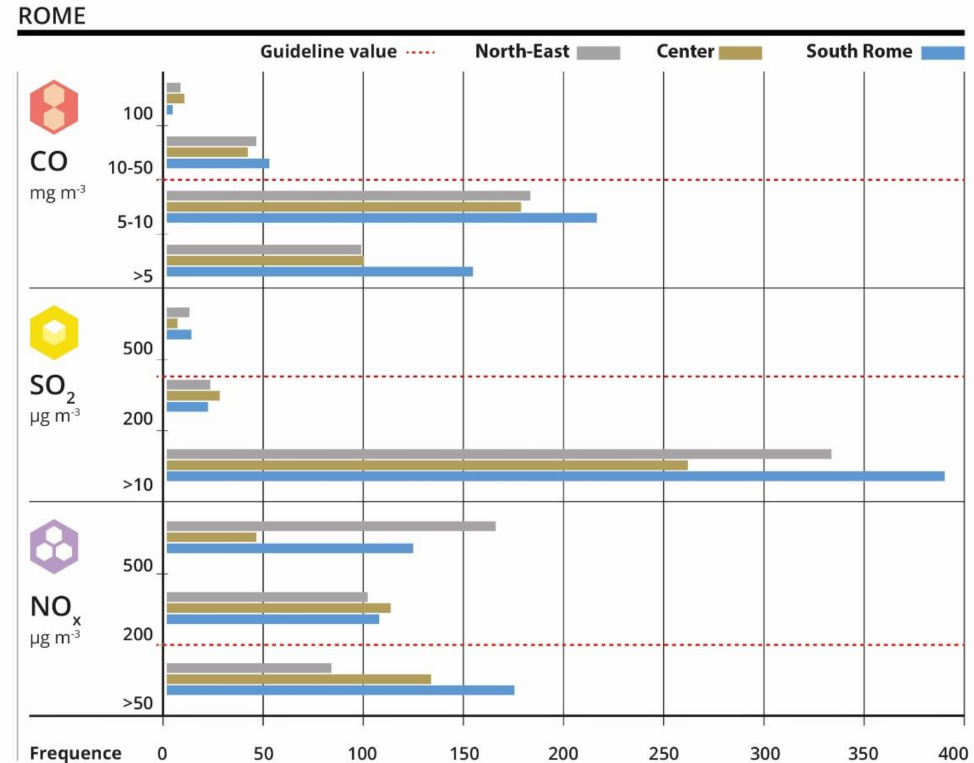
Figure 6. Frequency of the concentration classes of the three gases, CO, SO 2 and NO x , grouped by geographic areas. The histograms indicate the gas concentrations averaged with respect to the areas of the City of Rome, gray for the Northeast, bronze for the Center, and blue for the South. The symbolism of the gases is that adopted by the European Environment Agency. The red lines indicate the guideline values suggested by EC [26] and WHO [27]: carbon monoxide (CO) 10 mg m − 3 8-h − 1 daily mean; sulfur dioxide (SO 2 ) 20–125 µ g m − 3 24-h − 1 , 350 µ g m − 3 h − 1 , 500 µ g m − 3 10-min − 1 ; nitrogen